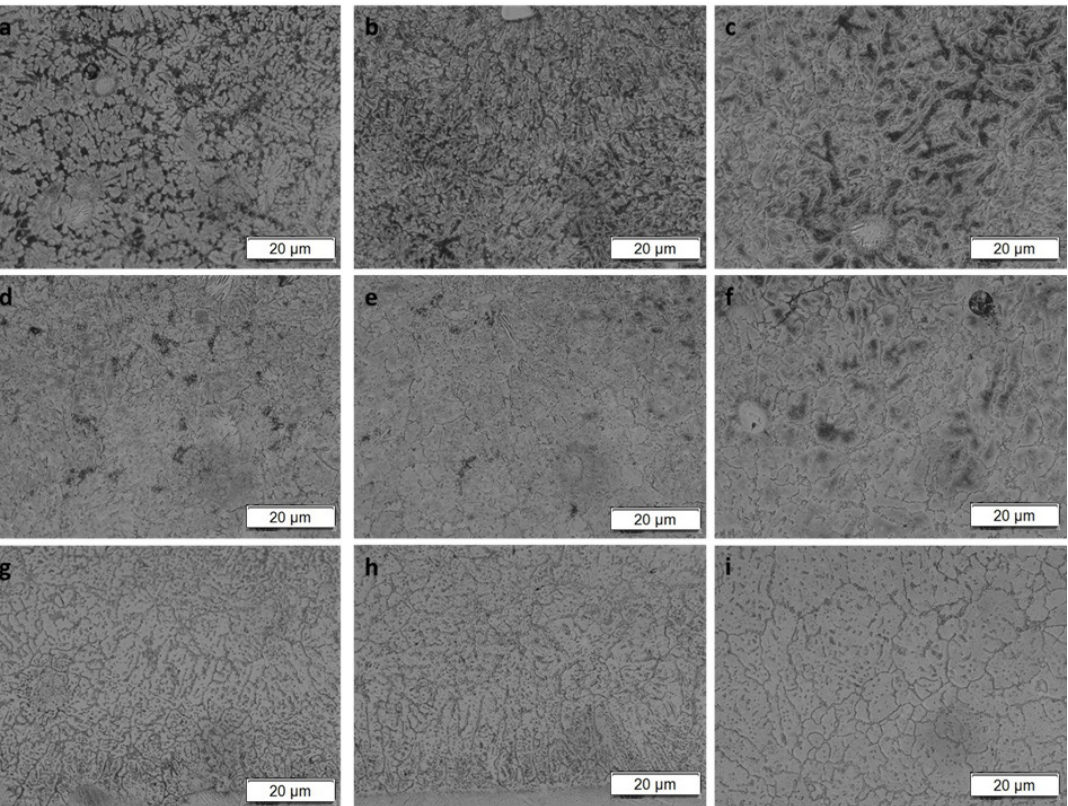
Figure 2. Optical microscope micrographs of Ti-Si-Fe-Cr-Nb alloy fabricated at 800W (a, d and g: top, middle and bottom layers), 1000W (b, e and h: top, middle and bottom layers) and 1200W (c, f and i: top, middle and bottom